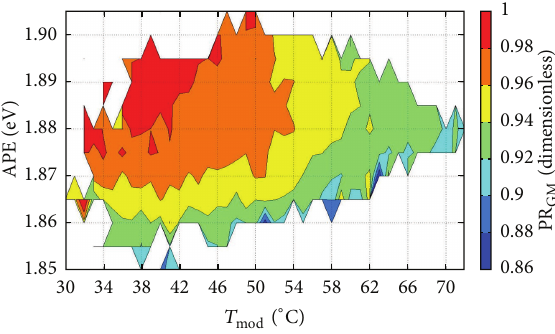
Figure 6: Contour graph of PR GM of the tested a-Si:H/ 𝜇 c-Si:H PV module as a function of 𝑇 mod and APE. Blank areas indicate no data points.